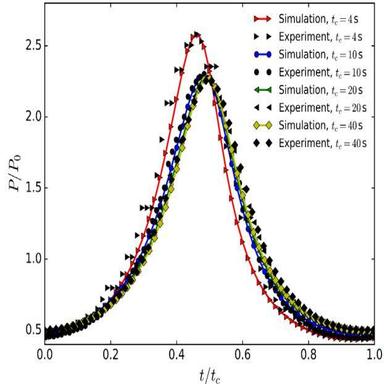
Comparison of the pressure profiles for the CO2 runs in the packed bed with different cycle times. Conditions: T0 = 30 C; u ¼ 0; Stroke1 = Stroke2 = 0–100 mm.